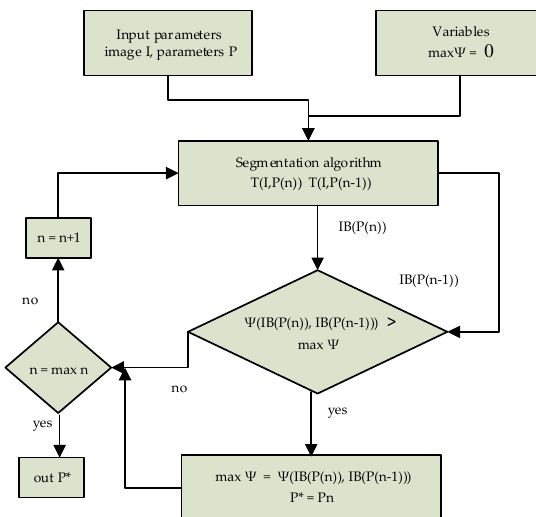
Figure 3. Flowchart of the Parametric Segmentation Tuning technique. The iterative process is carried out by modifying the segmentation parameters of the technique to be tuned, which is used to create the space of binary images. They will be compared to get the best result using as criteria a similarity indicator.